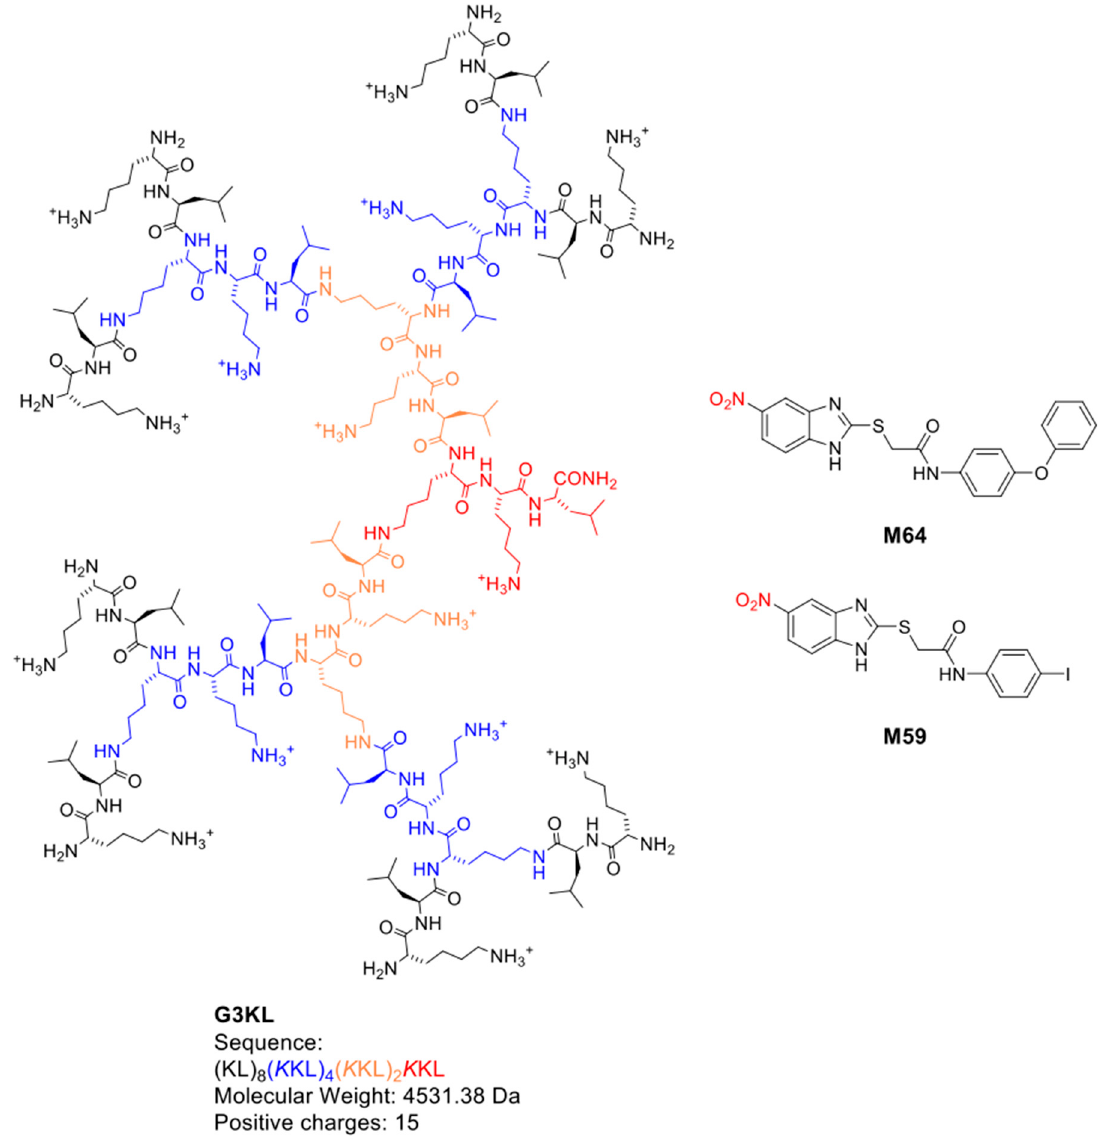
Figure 1. Chemical structure and sequence of antimicrobial peptide dendrimers (G3KL) and QS-inhibitor compounds (M59 and M64) tested in the present study. G3KL; third-generation dendrimer. First, second, and third generation residues are indicated in orange, blue, and black color, respectively. One letter codes for amino acids: (l, leucine; k, lysine). M95 and M64.